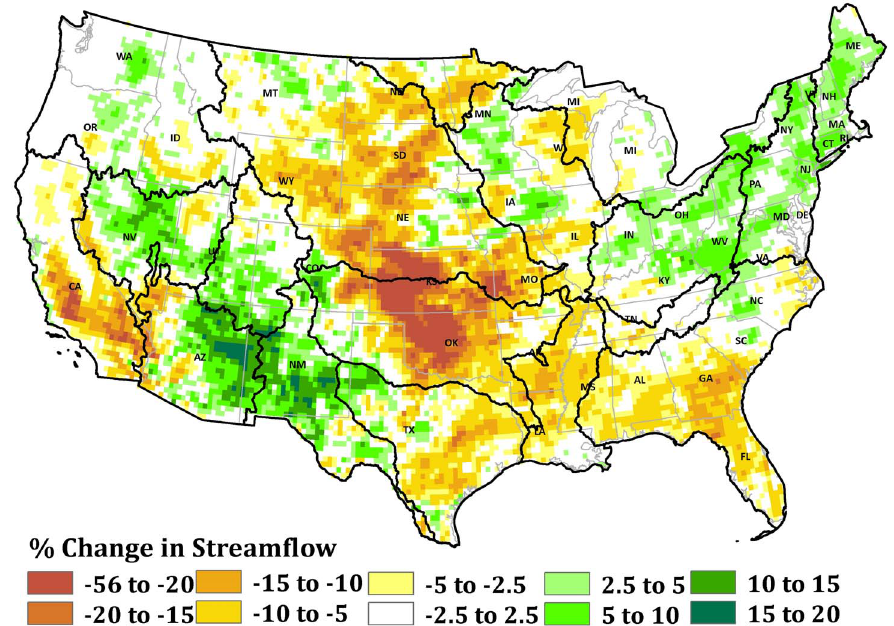
Figure 5. Percent change in mean annual streamflow as a function of change in annual precipitation and potential evapotranspiration under the biofuel scenario.